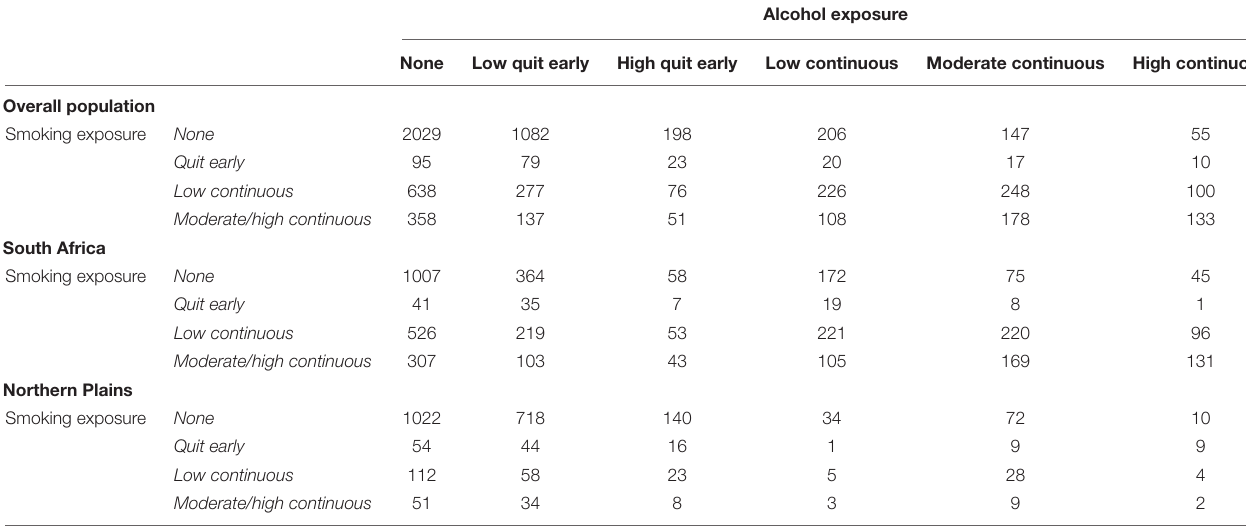
TABLE 2 | Cross Tabulation of smoking and drinking groups in the overall population, South Africa population, and Northern Plains population.